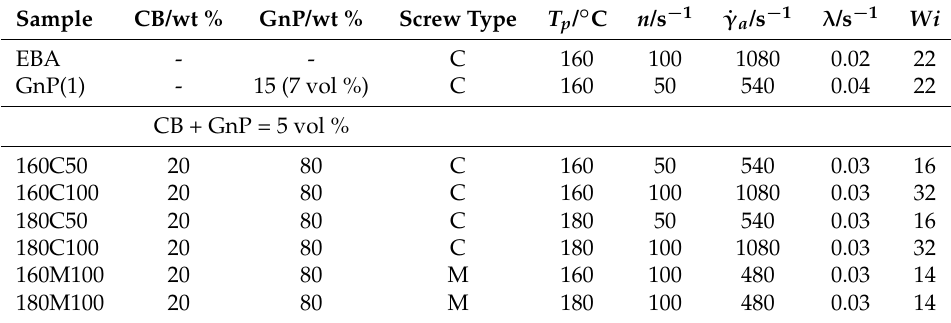
Table 1. Polymer nanocomposite samples characterized: composition and processing method. The following notations are used: CB, carbon black; GnP, graphite nanoplatelets; T p ,